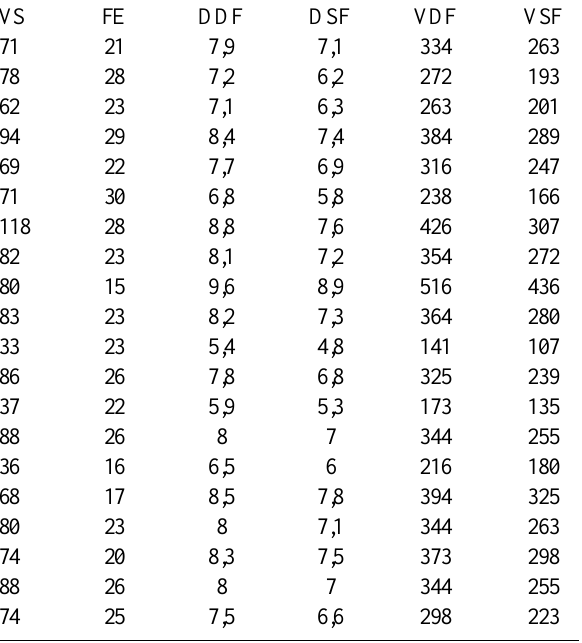
Tabela 2. Variáveis ecocardiográficas pré-operatórias.